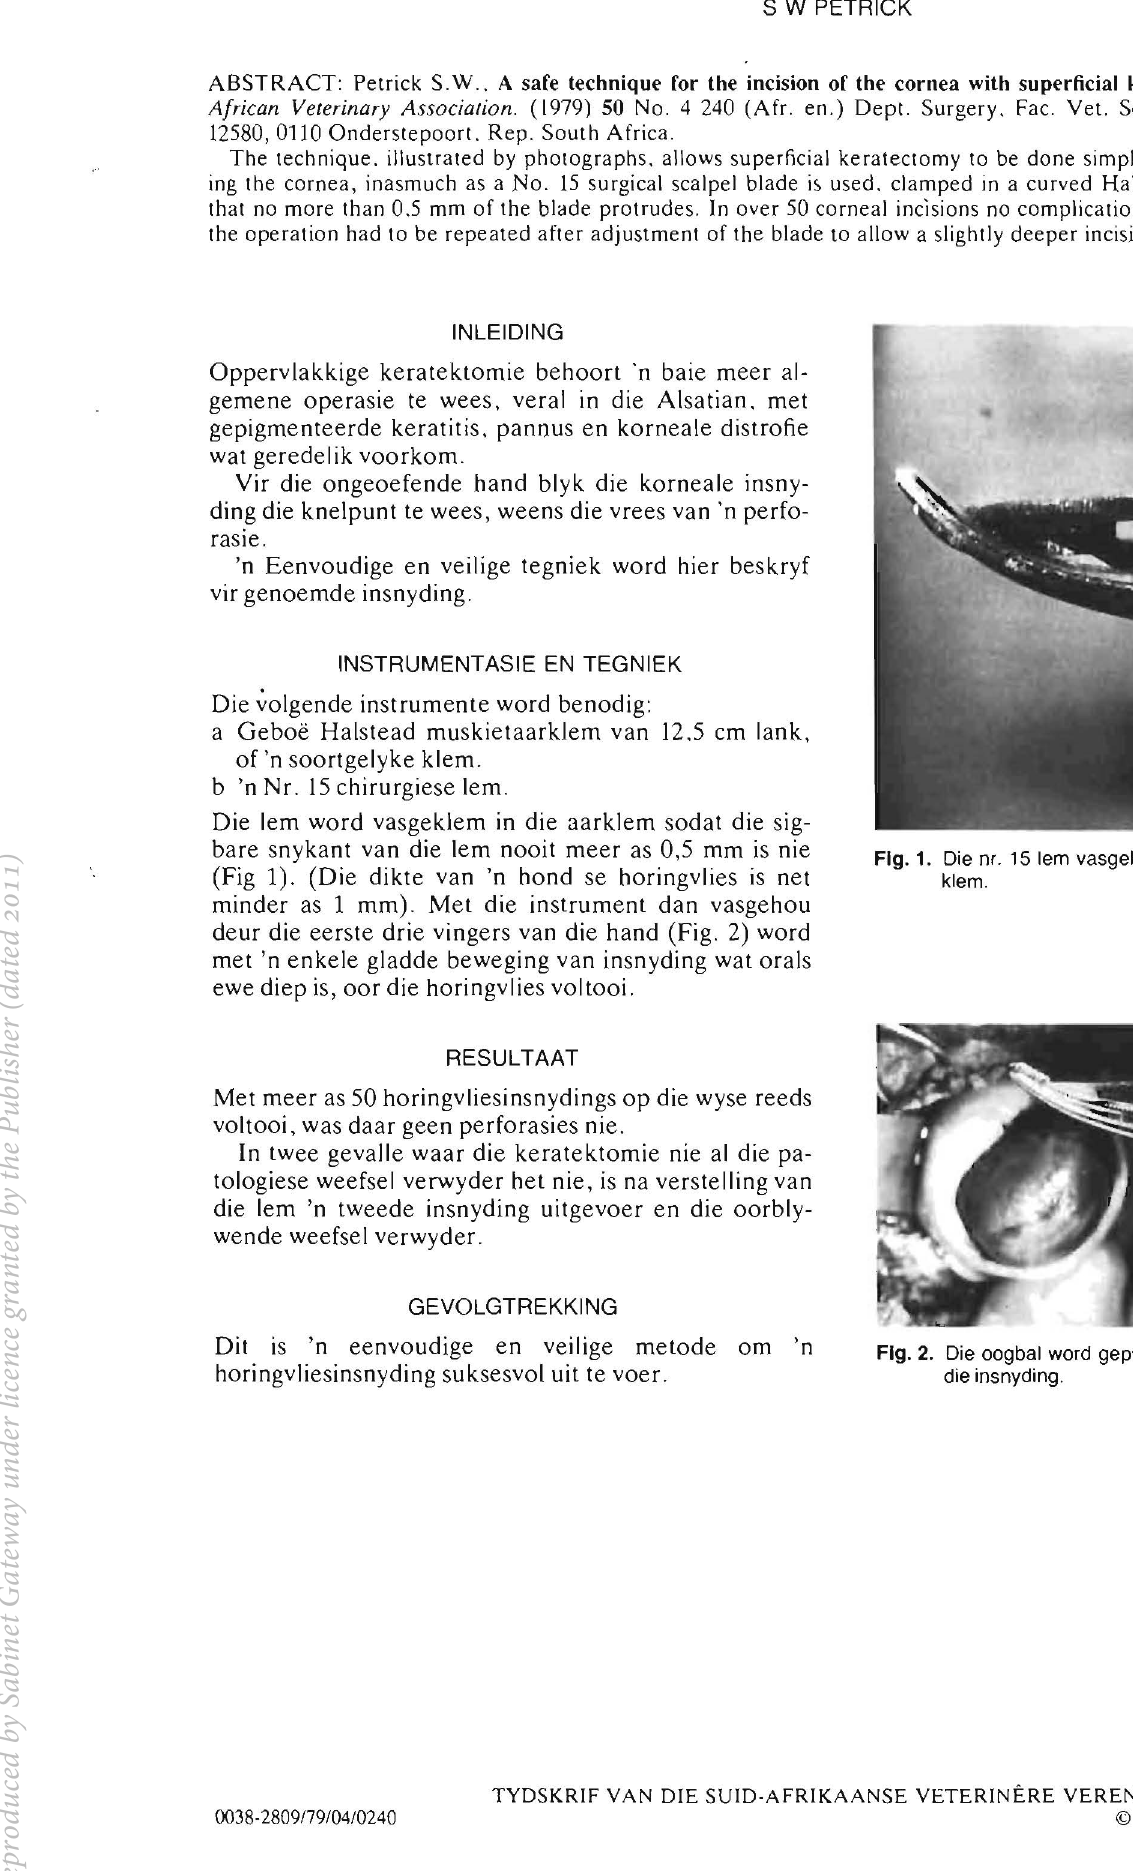
Fig. 2. Die oogbal word geprolabeer: die beskute lem is gereed vi) die insnyding.